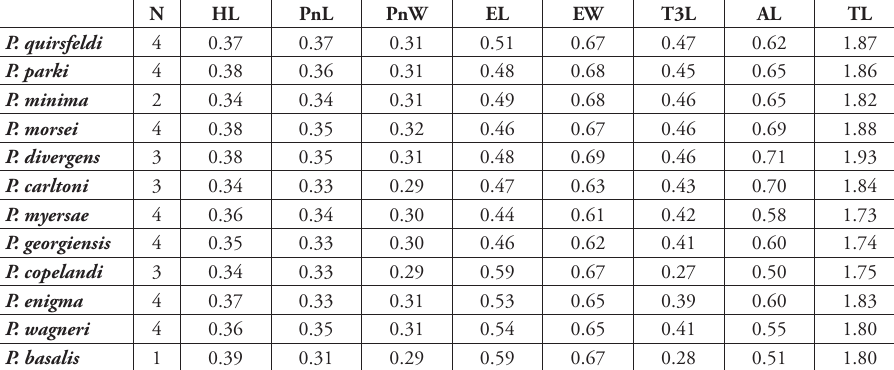
Table 1. Average measurements (in mm) of important body dimensions. N shows numbers of specimens measured for each